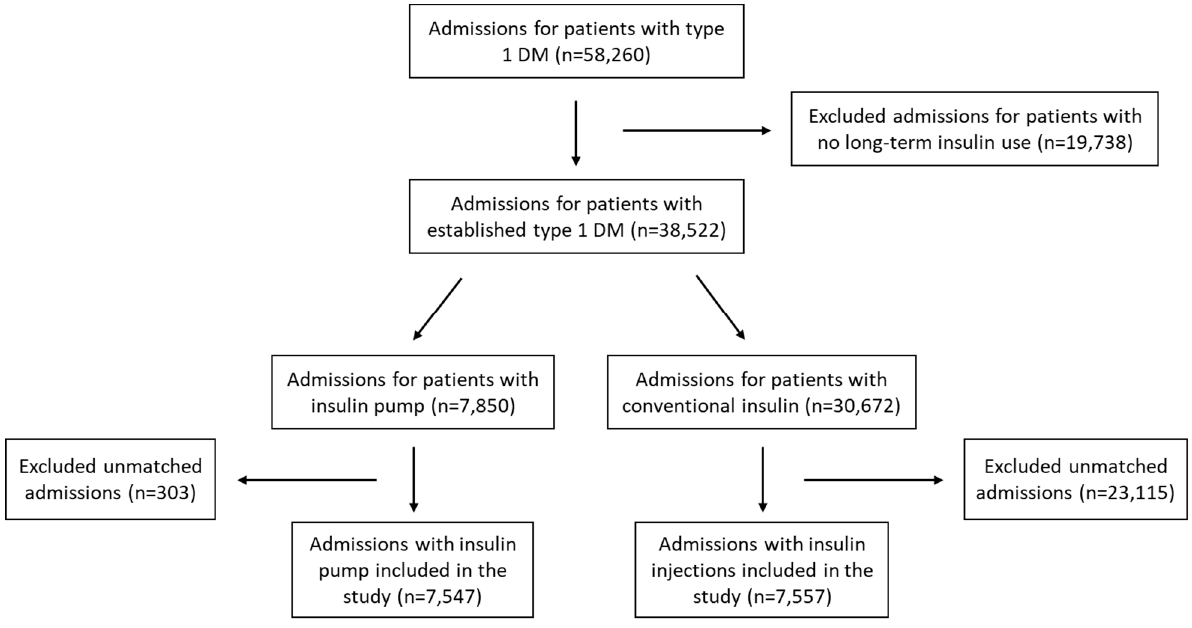
Figure 1. Flowchart of admissions selection in the study.